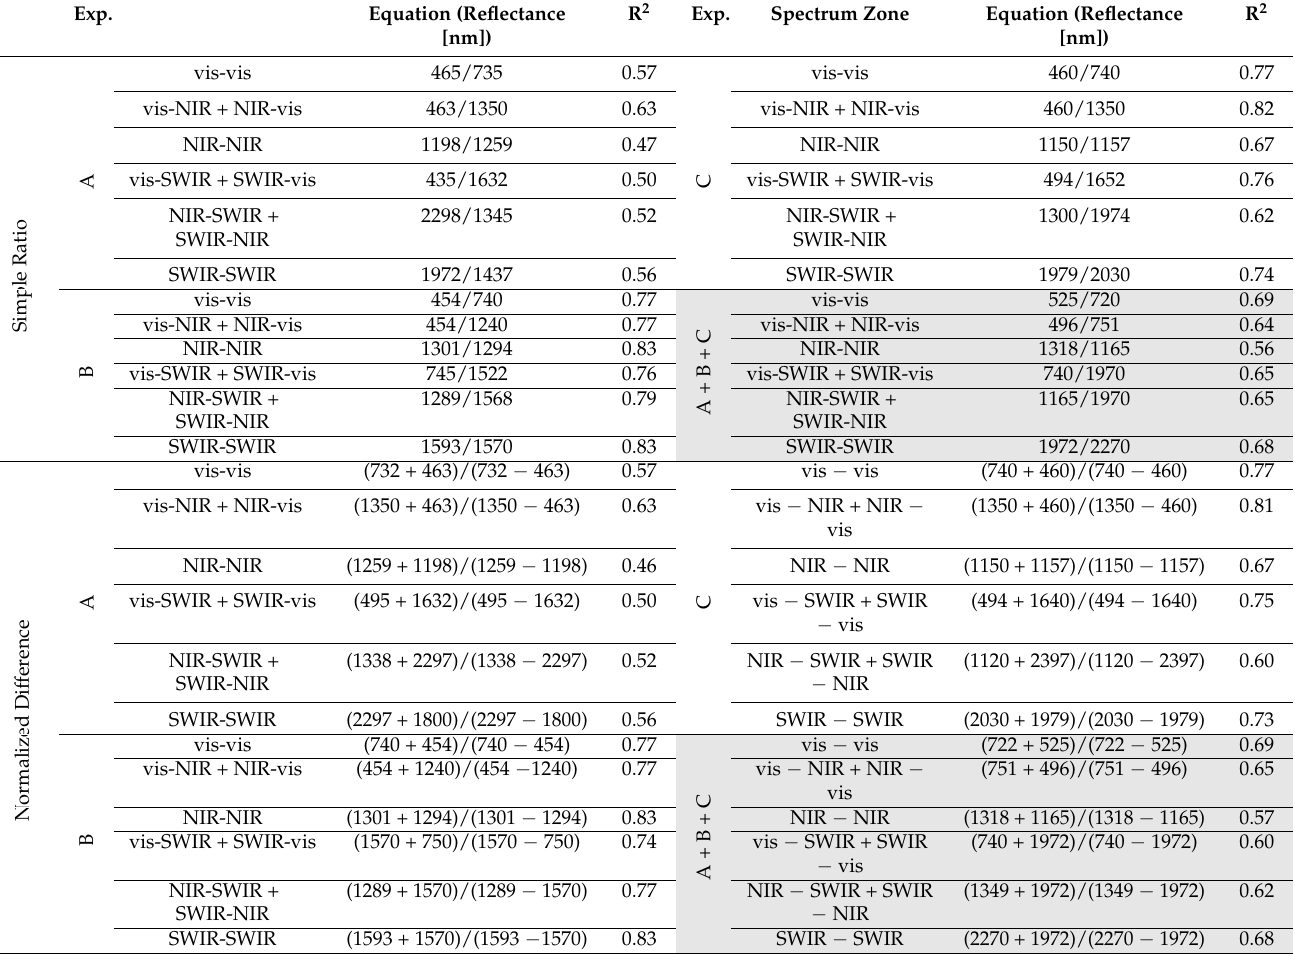
Table 8. Best-performing Vegetation Indexes (VIs) for the coefficient of determination (R 2 ) with nitrate content ([Nitrate]) in spinach leaves, as recorded in Exp. A, Exp. B, and Exp. C (see Table 1 for further details) as well as Exp. A+B+C altogether (grey background). Numbers refer to reflectance at wavelength expressed in nm; vis, NIR, and SWIR refer to the spectral zones ranging from 450:750 nm, 751:1349 nm, and 1411:2400 nm,